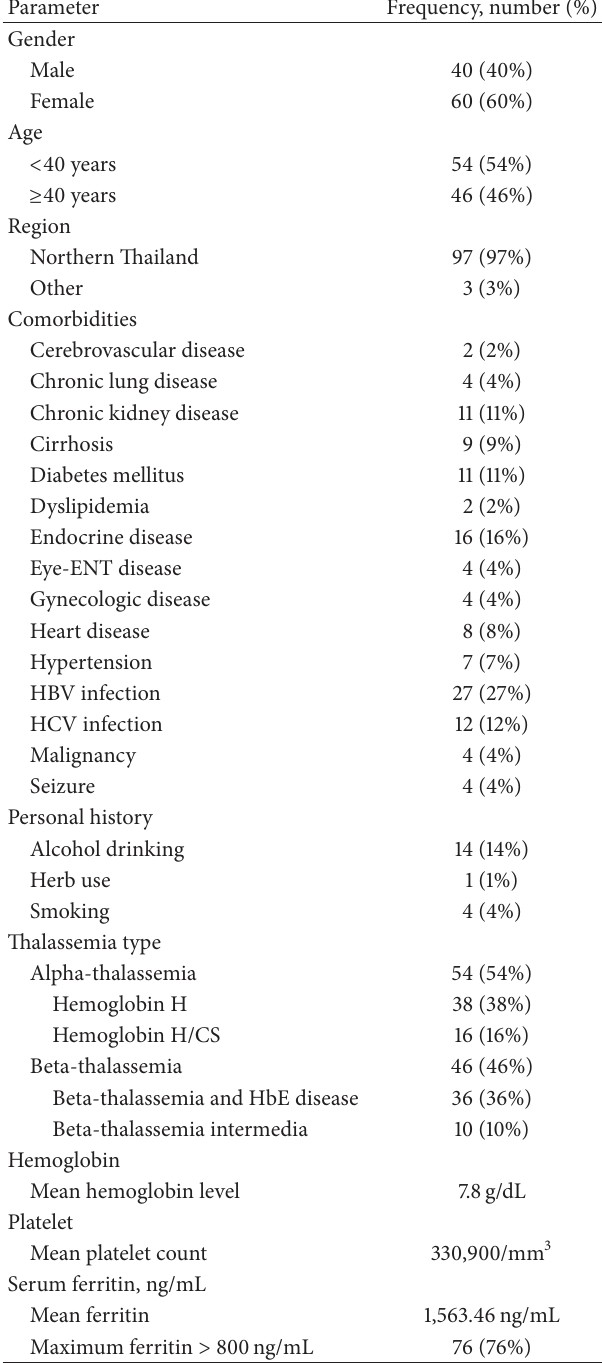
Table 2: Characteristics of the study